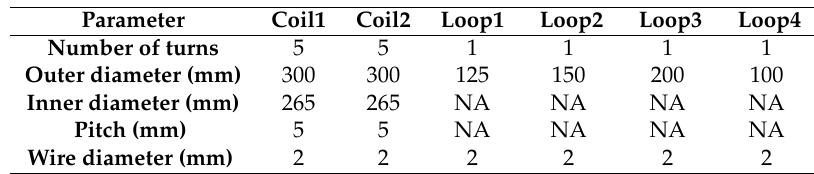
Table 1. Structural dimensions of the fabricated coils and loops.